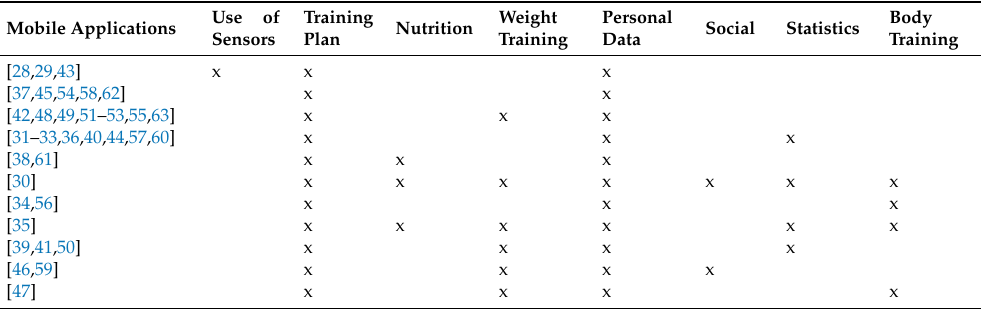
Table 7. Distribution of mobile application by